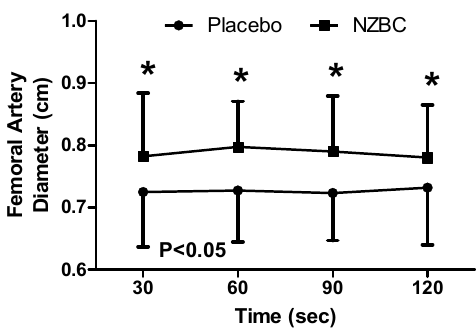
Figure 4. Femoral artery diameter during a 120-s 30%iMVC of the quadriceps muscle for placebo and after 7-days intake of NZBC (New Zealand blackcurrant) extract capsules. Data are mean ± SD. * difference between placebo and NZBC extract.